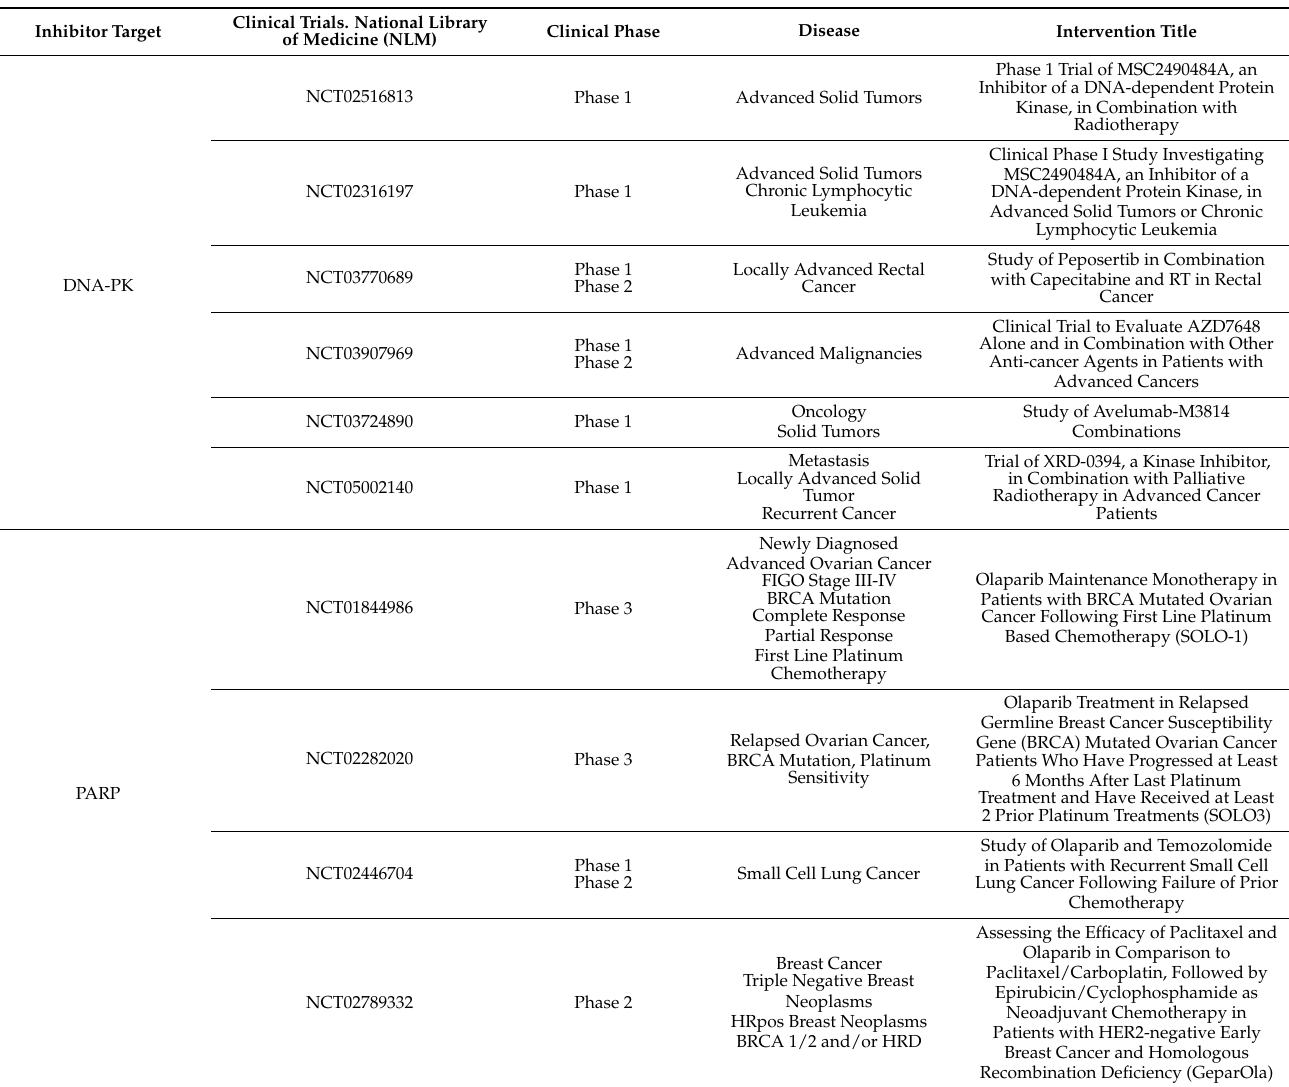
Table 2. Cancer therapeutic treatment inhibitors and their targets, identified using the clinicaltrials. gov (4 January 2023)